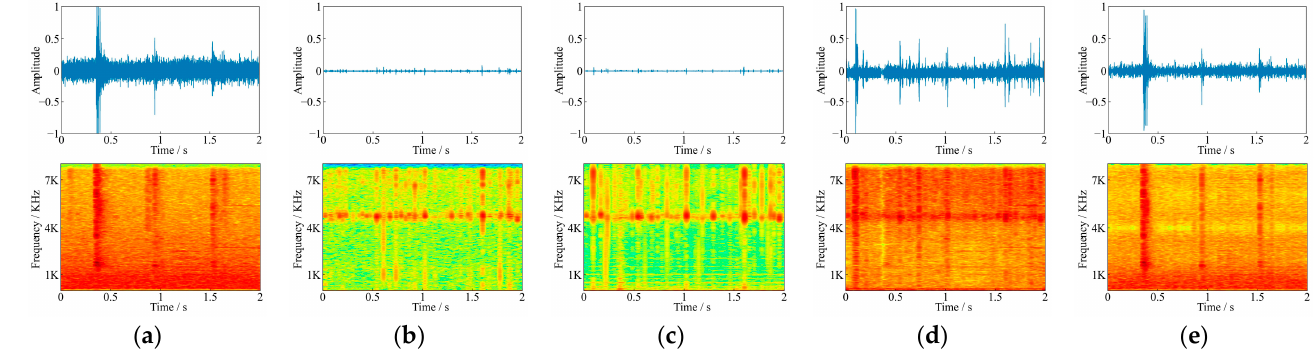
Figure 11. Comparison of waveforms and spectrograms before and after denoising for the noisy feeding sound at − 24 dB ( a ) the noisy feeding sound at − 24 dB; ( b ) corresponding pure feeding sound; ( c ) the denoising result of TDD-Net-DC; ( d ) the denoising result of FDD-Net-BL; and ( e ) the denoising result of wavelet denoising.